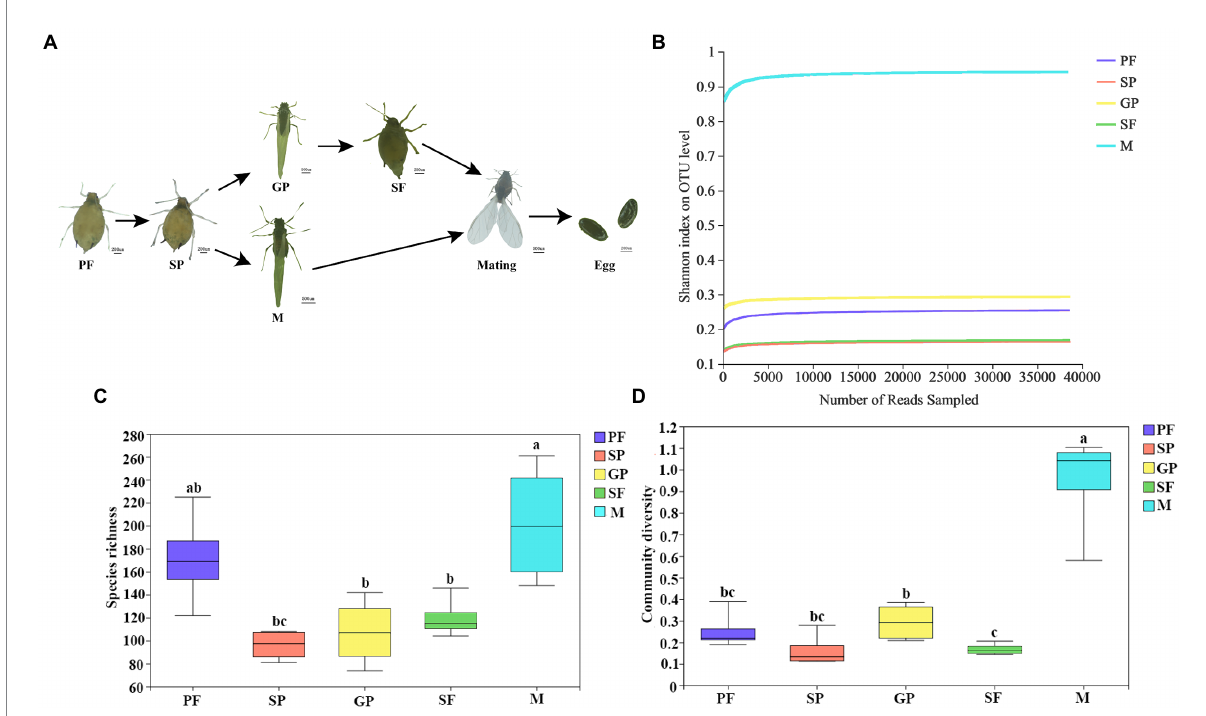
FIGURE 1 Schematic of life cycle of five morphs and dynamics of symbiotic bacterial species richness and community diversity in A . gossypii . (A) Overview of life cycle of 5 aphid morphs. (B) Rarefaction curves of bacterial community Shannon index with four biological replicates for each morph at the OTU level. (C) Boxplot of species richness evaluated by OTUs number. (D) Bacterium community diversity evaluated by Shannon index. Different lower-case letters represent significant differences ( p < 0.05) revealed by one-way ANOVA. PF, parthenogenetic females; SP, sexuparae; GP, gynoparae; SF, sexual females; and M,